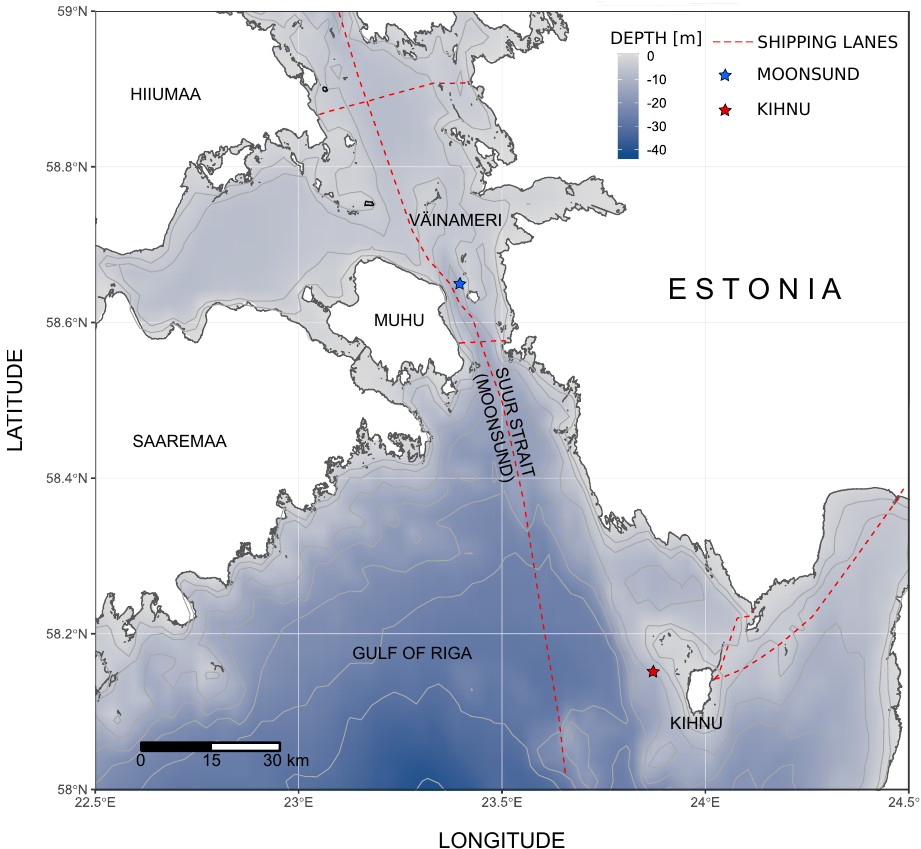
Figure 1. Sound monitoring locations in Kihnu (58.149° N, 23.873° E) and Moonsund (58.651° N, 23.393° E), marked by